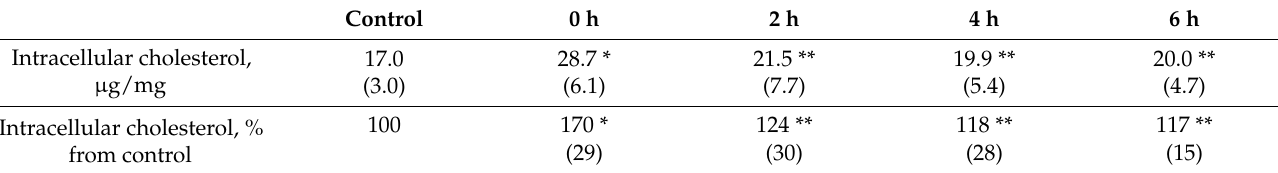
Table 2. Blood serum atherogenicity after licorice root powder